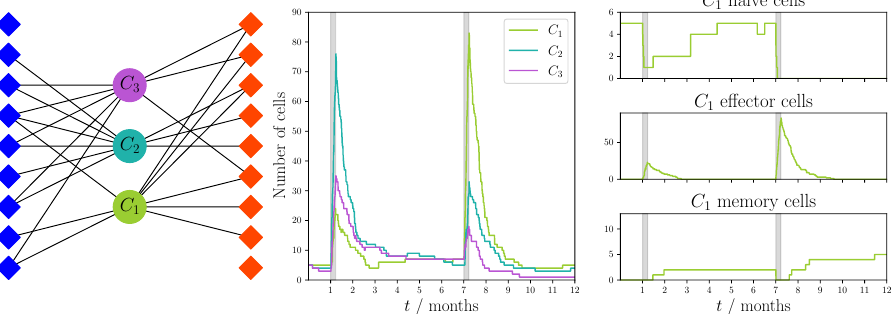
Figure 10. Single realization of an immune response to two viral challenges with an unfocused recognition network and dynamics defined in Section 5.1. The network was constructed using the sampling strategy described in Section 4.1.1 with probability of success p = 8/18. Blue diamonds represent VDPs present during the first viral challenge and red diamonds represent those present during the second challenge. We note that not every VDP was recognized by the clonotypes, since the samples were drawn in a random fashion, and there was always a probability 1 − p of no recognition between the chosen clonotype and a VDP. Model parameters are described in Table 2. The python code used to generate this figure has been made available at https://doi.org/10.5281/zenodo.5227343